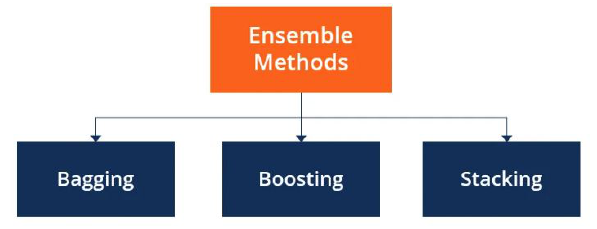
Figure 3. Types of ensemble